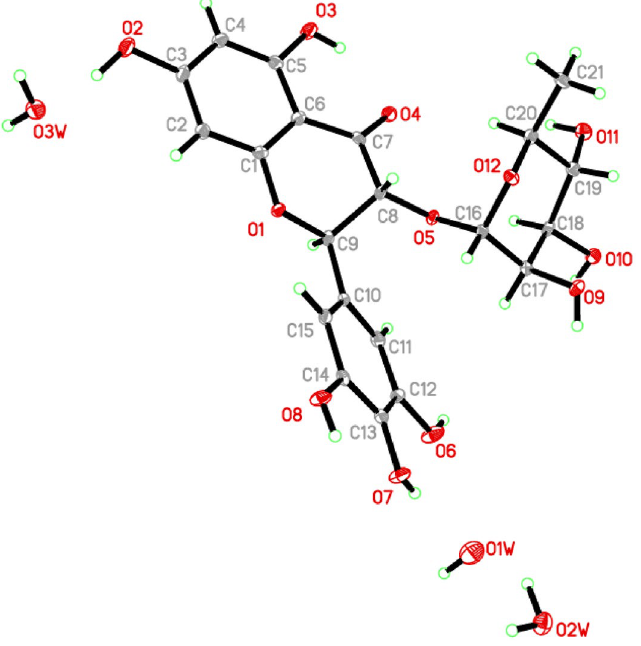
Figure 2. ORTEP of compound 1 . Non-H atoms have their displacement ellipsoids depicted at a 40% probability